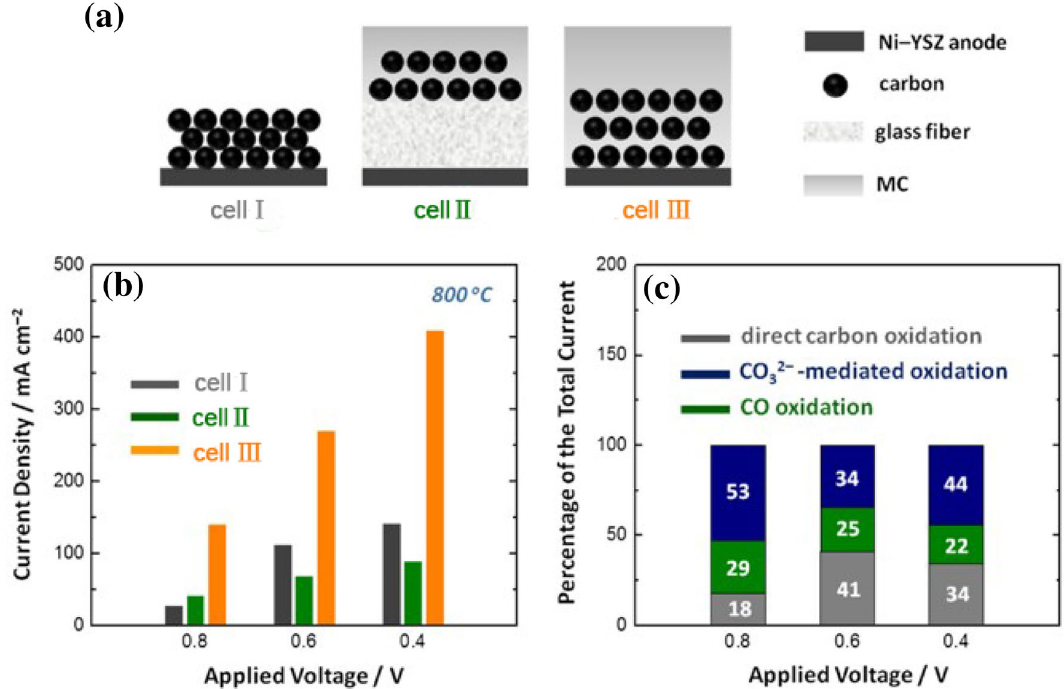
Fig. 6 The relationship between the different contact modes of the anode and the cell performance of DCFC: a three different contact methods for carbon fuel and the anode; b comparison of current den-